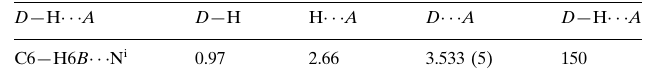
Hydrogen-bond geometry (A˚ , (cid:2)